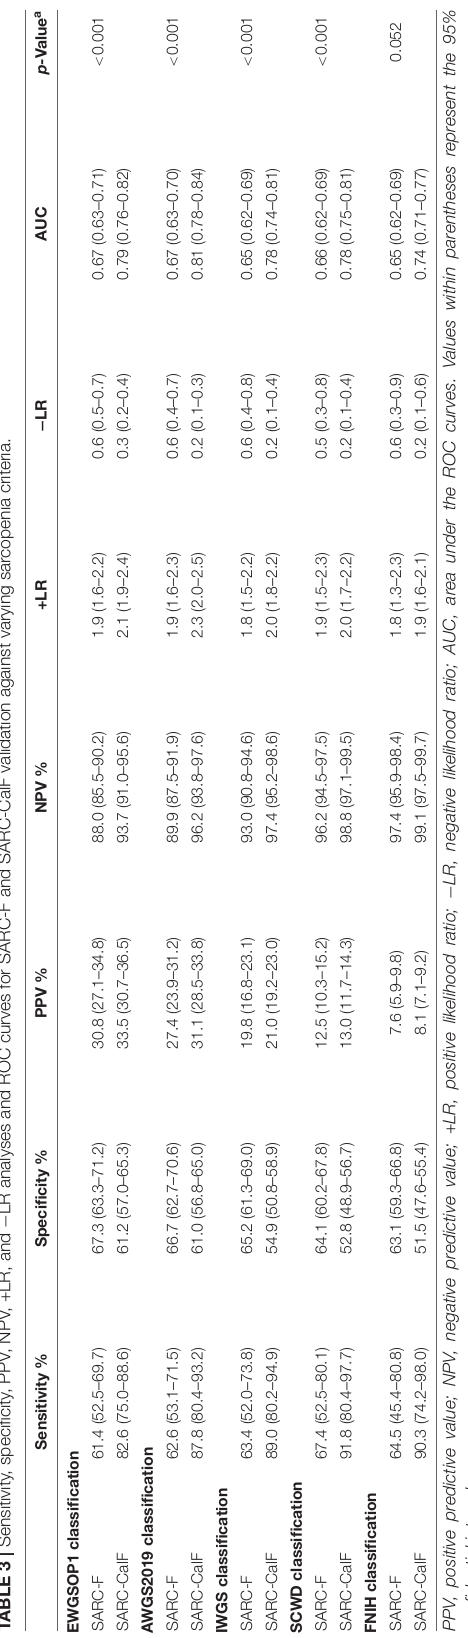
TABLE 2 | Characteristics of the study